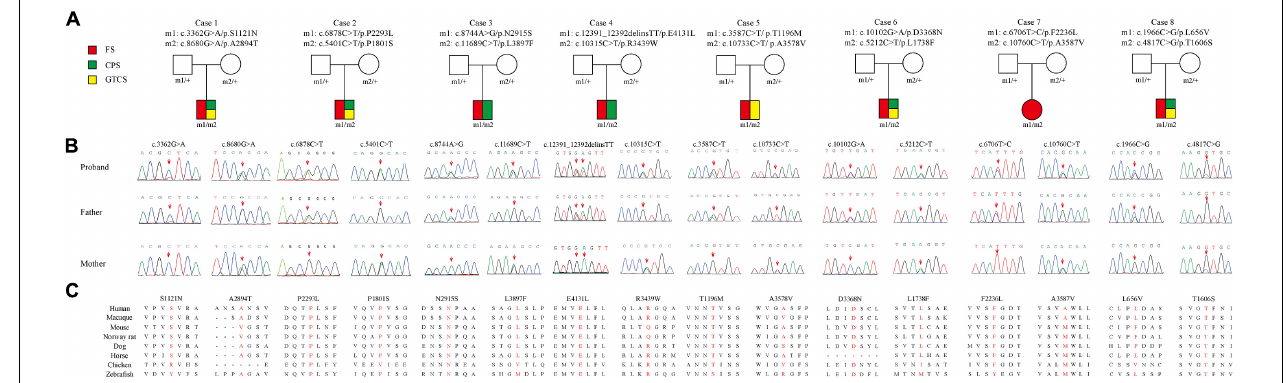
FIGURE 1 | Genetic data of cases with PKD1 mutations. (A) Pedigrees of eight cases with compound heterozygous PKD1 missense mutations and their corresponding phenotypes. FS, febrile seizure; CPS, complex partial seizure; GTCS, generalized tonic-clonic seizure. (B) DNA sequencing chromatogram of PKD1 mutations. Arrows indicate the positions of the mutations. (C) Amino acid sequence alignment of the sixteen missense variants show that residues P2293L, N2915S, E4131L, D3368N, and T1606S are highly conserved in various species; S1121N, P1801S, L3897F, T1196M, L1738F, and F2236L were likely to be highly conserved across mammalian species; while L656V, A2894T, R3439W, A3578V, and A3587V are less conserved.